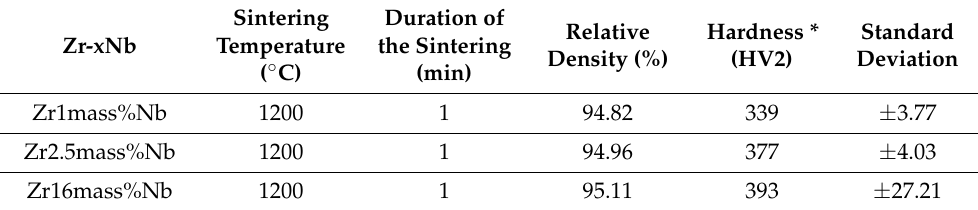
Table 1. The SPS process parameters, relatively densities, hardness of the sintered Zr-xNb materials obtained from mixtures with the 1–5 µ m niobium powder, milled in isopropyl alcohol.